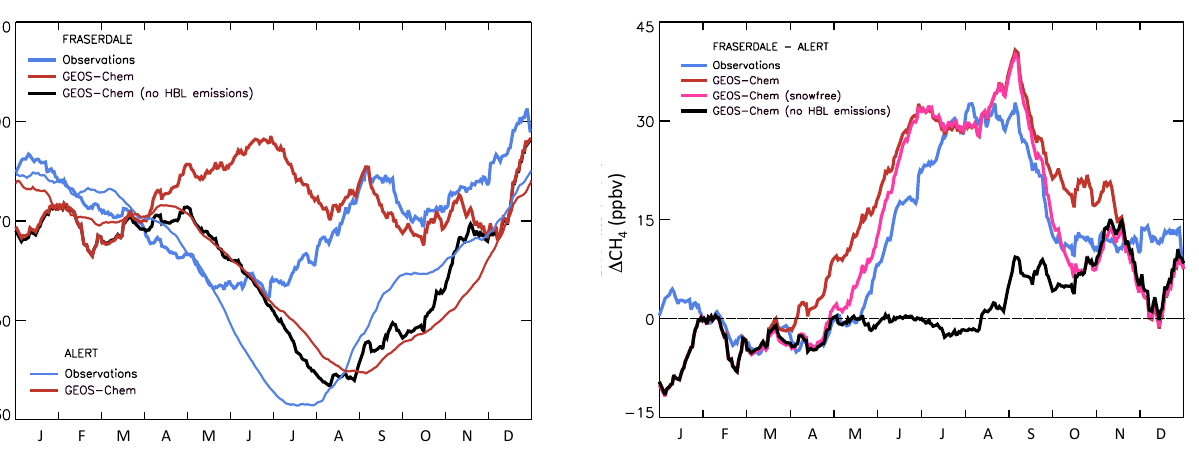
Fig. 3. Seasonal variation (2004–2008) of methane at Fraserdale and Alert. GEOS-Chem results are compared to observations. Also plotted is the model background concentration at Fraserdale as de- rived from a simulation with no HBL emissions. Data are daytime values smoothed with a 28-day moving average and then averaged over 5yr. For Fraserdale we use only data associated with winds from the northern quadrants.